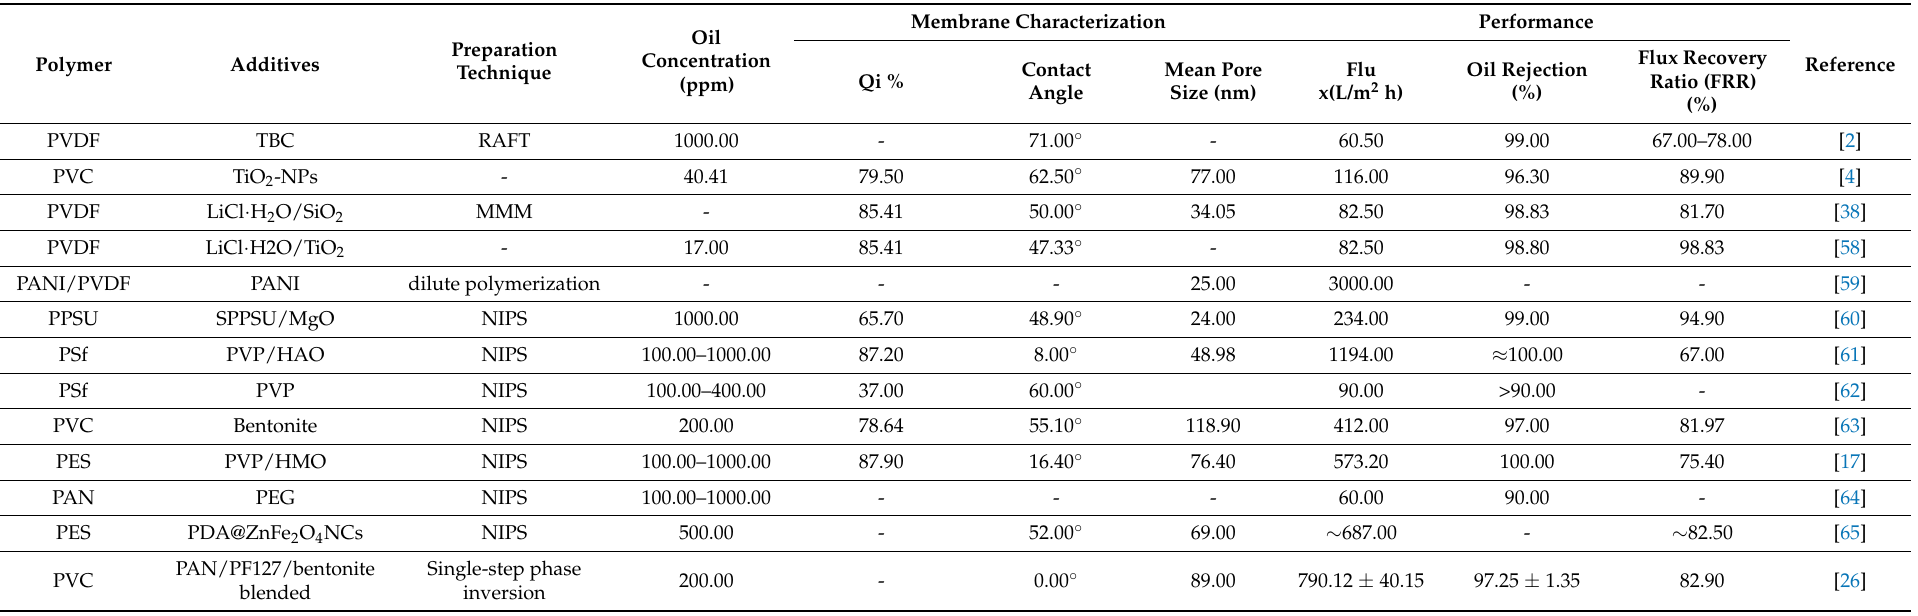
Table 7. Shows the summary on the UF membrane applications in oily wastewater with membrane characterization and